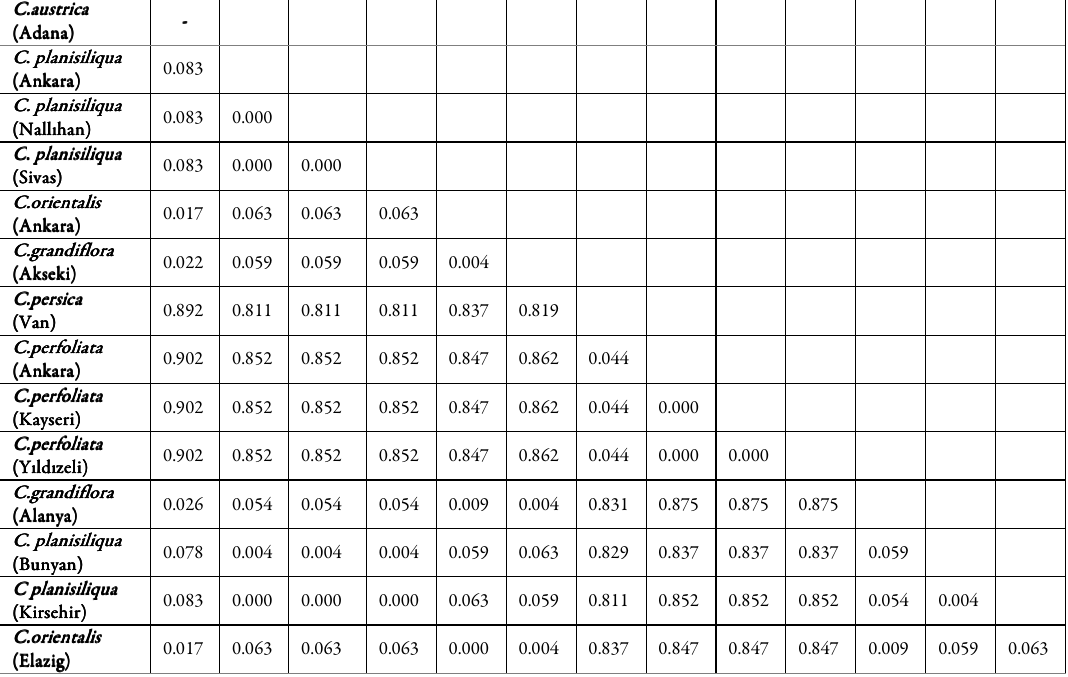
Table 4. Pairwise genetic distance matrix obtained from cpDNA trn L-F